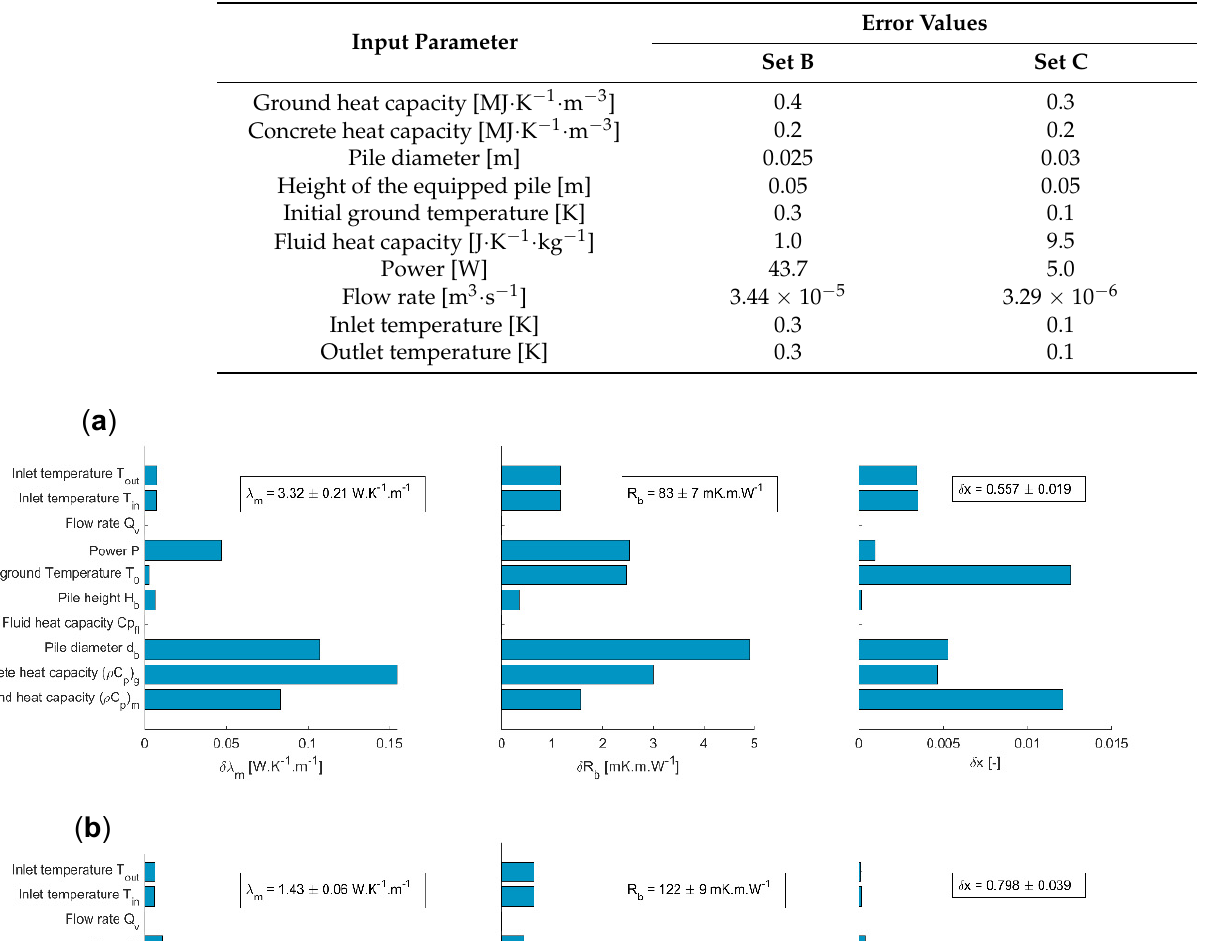
Table 2. Considered values for the error on the input parameters.